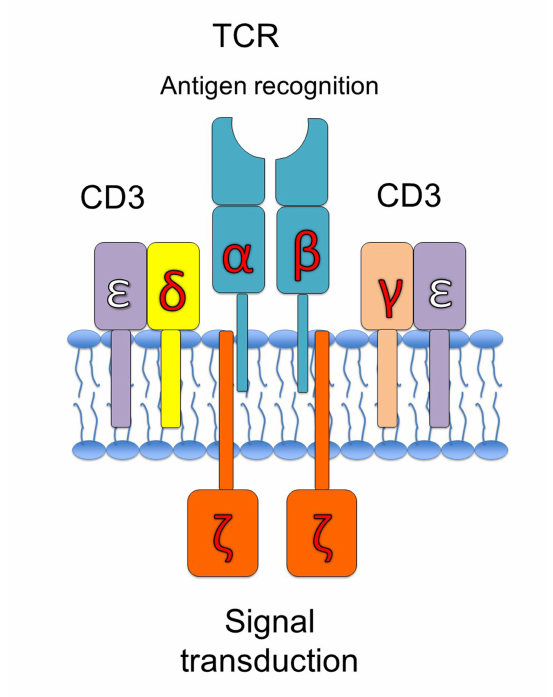
Figure 1. The diagram of TCR